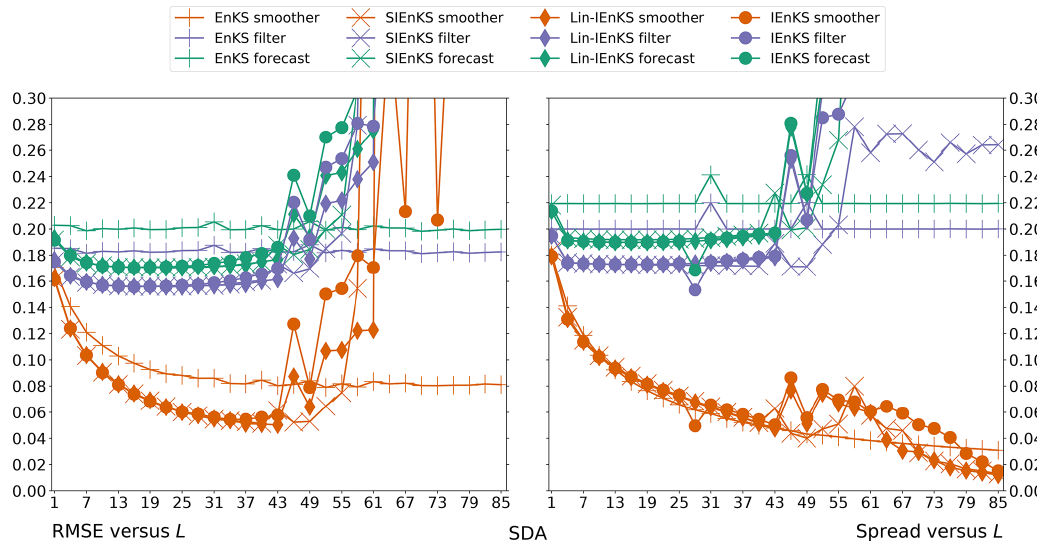
Figure 7. Cross section of Fig. 6 at the ensemble size N e =